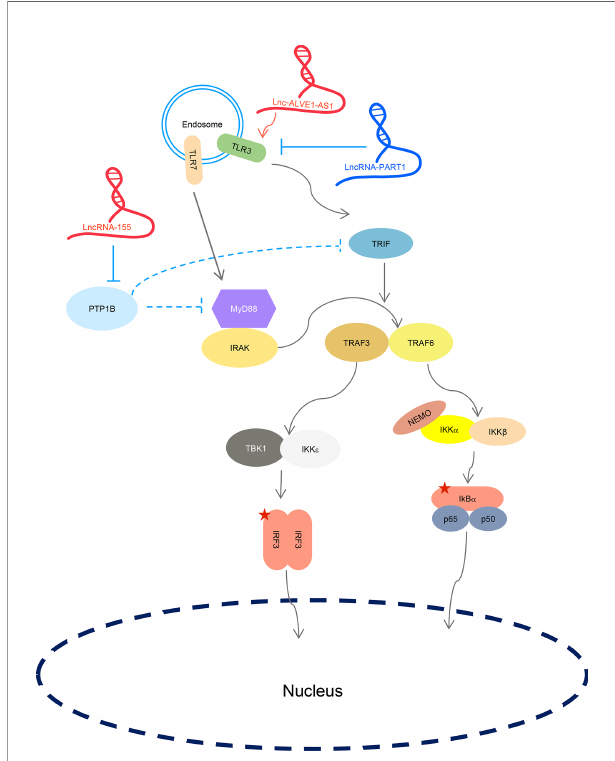
FIGURE 4 | LncRNAsregulateTLR-mediatedIFNsignaling.LncRNAALVE1-AS1 enhancesTLR3-mediatedIFNsignaling.LncRNA-155targetsPTP1B.LncRNA- PART1negativelyaffectsTLR-mediatedIFNsignaling. “ U ” representsubiquitination modi fi cation.Five-sidedstarrepresentsphosphorylationmodi fi cation.LncRNAinblue